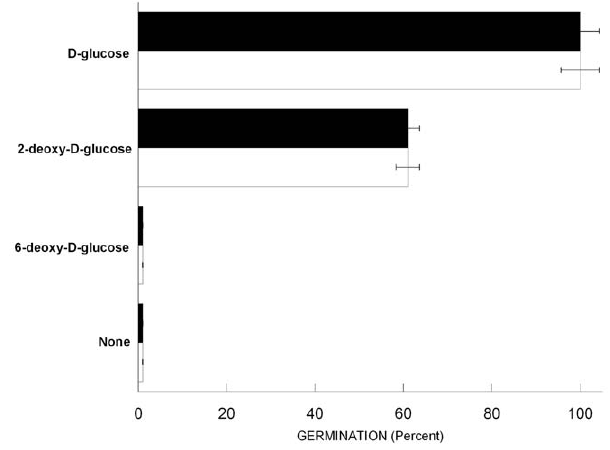
Figure 4. Germination kinetics of F-spores. B. megaterium F- spores (constructed with diacetylfluorescein) were induced to germi- nate by adding D-glucose (4 mM final concentration) at zero min, and fluorescence was measured at intervals as indicated in Materials and Methods. Black symbols: F-spores with germinant. White symbols: F- spores without germinant. Squares: Fluorescence. Circles: Optical density expressed as percentage of maximal loss (53%).